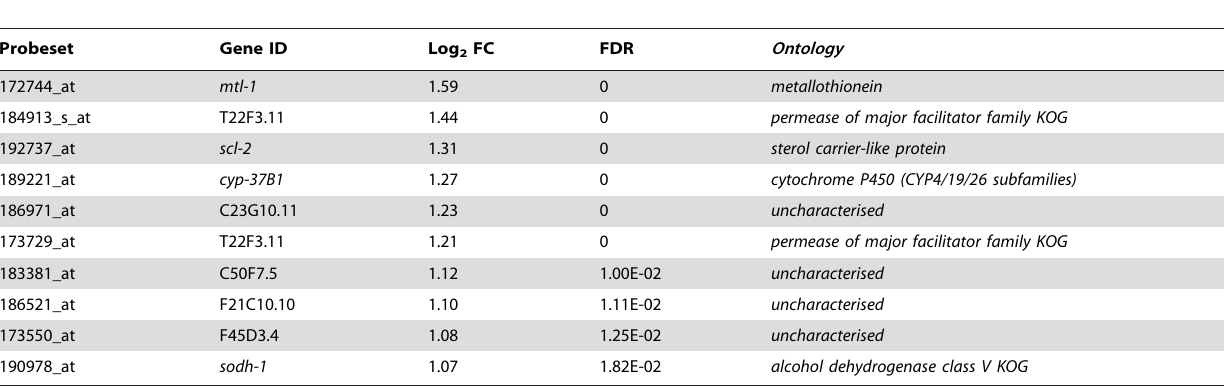
Table 1. Top 10 up-regulated probesets based on fold change following 4 hr exposure of DA1316 to 100 ng/ml (0.1 m M)